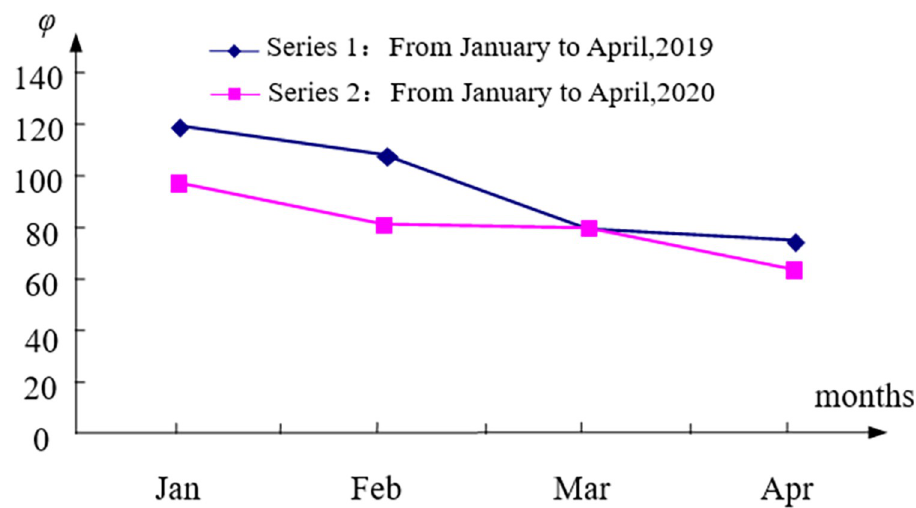
Fig 8. The change trend of comprehensive evaluation value of air quality.